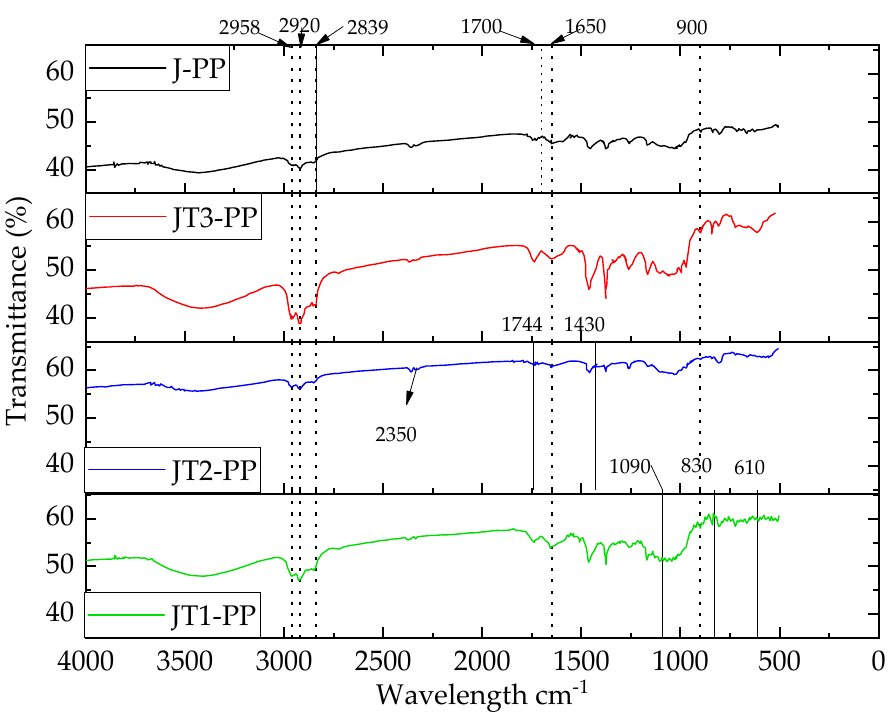
Figure 13. FTIR of MAgPP composites reinforced with chemically modified jute fiber (25 wt.%). Peaks at wavenumbers 2958, 2920, 2839, 1458, 1377, and 719 cm − 1 represented the characteristics of PP [40]. Furthermore, a peak at ~1744 cm − 1 indicated the symmetric C ≡ O stretching of anhydride functions grafted on PP [56].